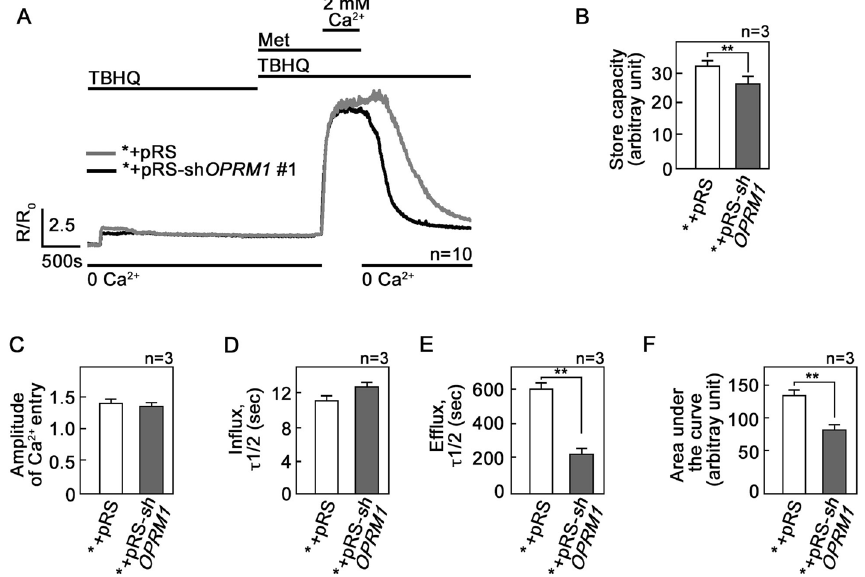
Figure 4. The rate of Ca 2+ extrusion following d,l-methadone treatment in leukemic cells is accelerated by loss of OPRM1. ( A ) External Ca 2+ entry and intracellular Ca 2+ extrusion in *+pRS and *+pRS-sh OPRM1 cells following d,l-methadone treatment. [Ca 2+ ] i was measured in cells loaded with Fura-2 AM and treated with TBHQ with or without d,l-methadone or external Ca 2+ using single-cell Ca 2+ imaging. Values represent means of Ca 2+ signal traces from 10 cells. ( B ) Internal Ca 2+ store capacity in OPRM1-depleted *+pRS-sh OPRM1 cells is reduced compared to that in control *+pRS cells. Release of internal Ca 2+ stores upon treatment with TBHQ allows measurement of internal Ca 2+ store capacity. In the presence of d,l-methadone, there is no difference in ( C ) the amplitude of Ca 2+ entry and ( D ) the rate of [Ca 2+ ] i influx in *+pRS and *+pRS-sh OPRM1 cells. ( E ) The rate of Ca 2+ extrusion, represented by the decline in [Ca 2+ ] i following removal of external Ca 2+ , is faster (i.e., reduced T 1/2 ) in *+pRS-sh OPRM1 cells than in *+pRS cells. ( F ) Comparison of the integrated Ca 2+ signals [area under the curve from the start of the Ca 2+ signal (at 50 min) until 25 min later (at 75 min)] shows decreased Ca 2+ transient in *+ pRS-sh OPRM1 cells compared to *+pRS cells. Values in (B)–(F) are means ± SEM from three independent experiments (n = 3). ** p < 0.025.